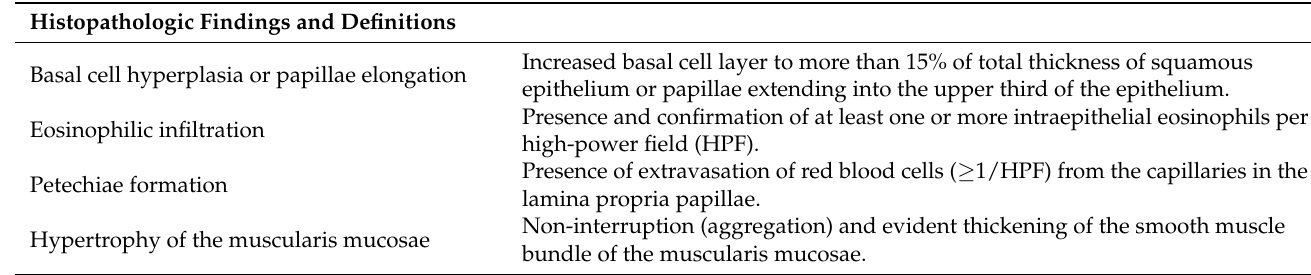
Table 1. Definition of histopathologic findings from esophageal mucosa biopsies.